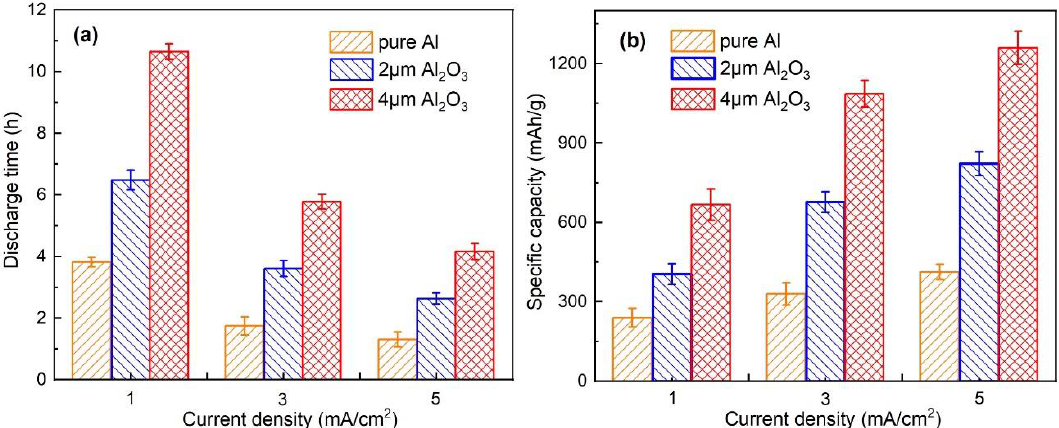
Figure 9. ( a ) Discharge time and ( b ) specific capacities of the Al–air batteries modified by an Al 2 O 3 interlayer with different thicknesses at different current densities.